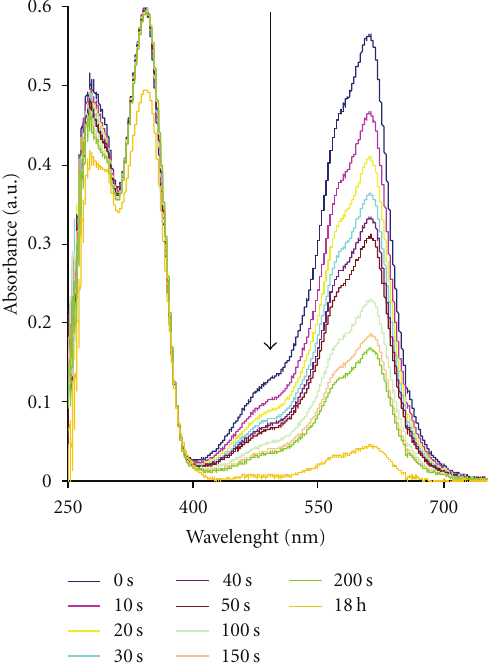
Figure 2: SPO-7OH in P(MMA-BMA) absorption spectra recorded before UV irradiation and after 200 s at 303 K.